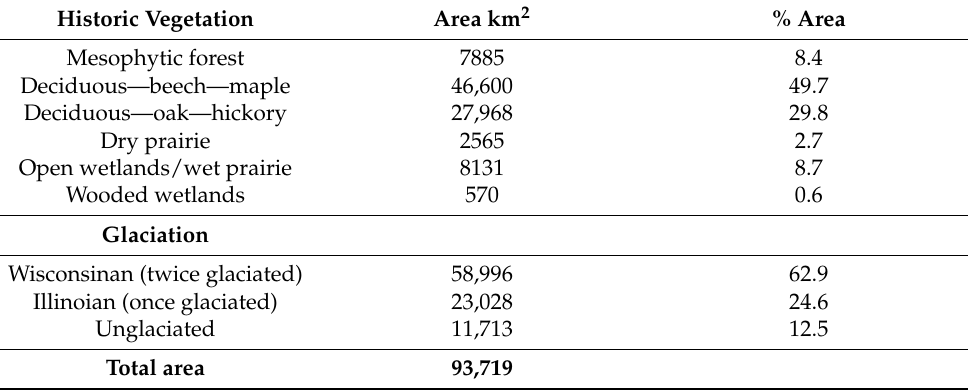
Table 1. Summary of Indiana historic vegetation and glaciation prior to European settlement.